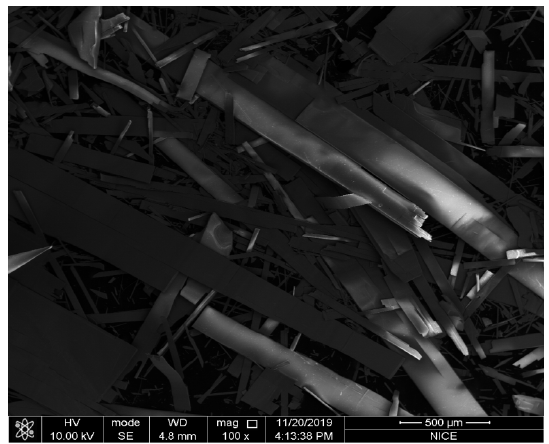
Figure 6. TG curves of DCLR (ER) -MoS 2 pyrolysis.